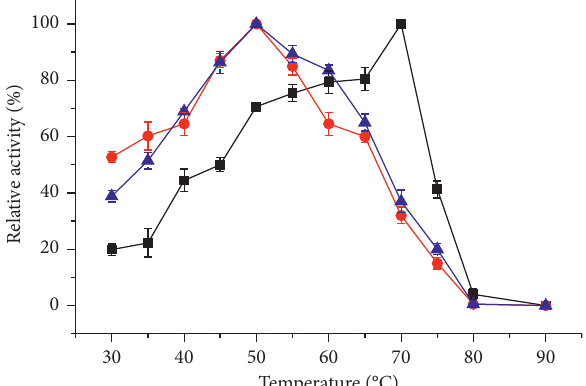
Figure 4: Effect of temperature on the endoglucanase ( ), exoglucanase ( ), and β -glucosidase ( ) activity. The error bars represent the mean ± SD ( n �